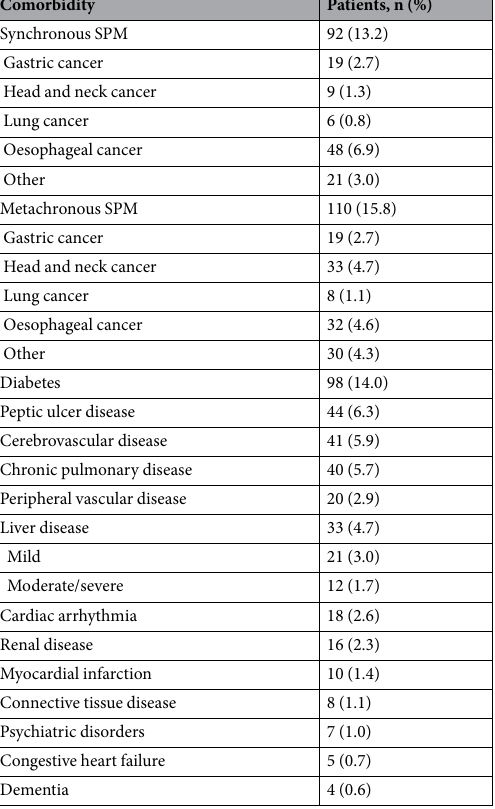
Table 2. Prevalence of comorbidities in patients with head and neck squamous cell carcinoma in the training set. SPM, secondary primary